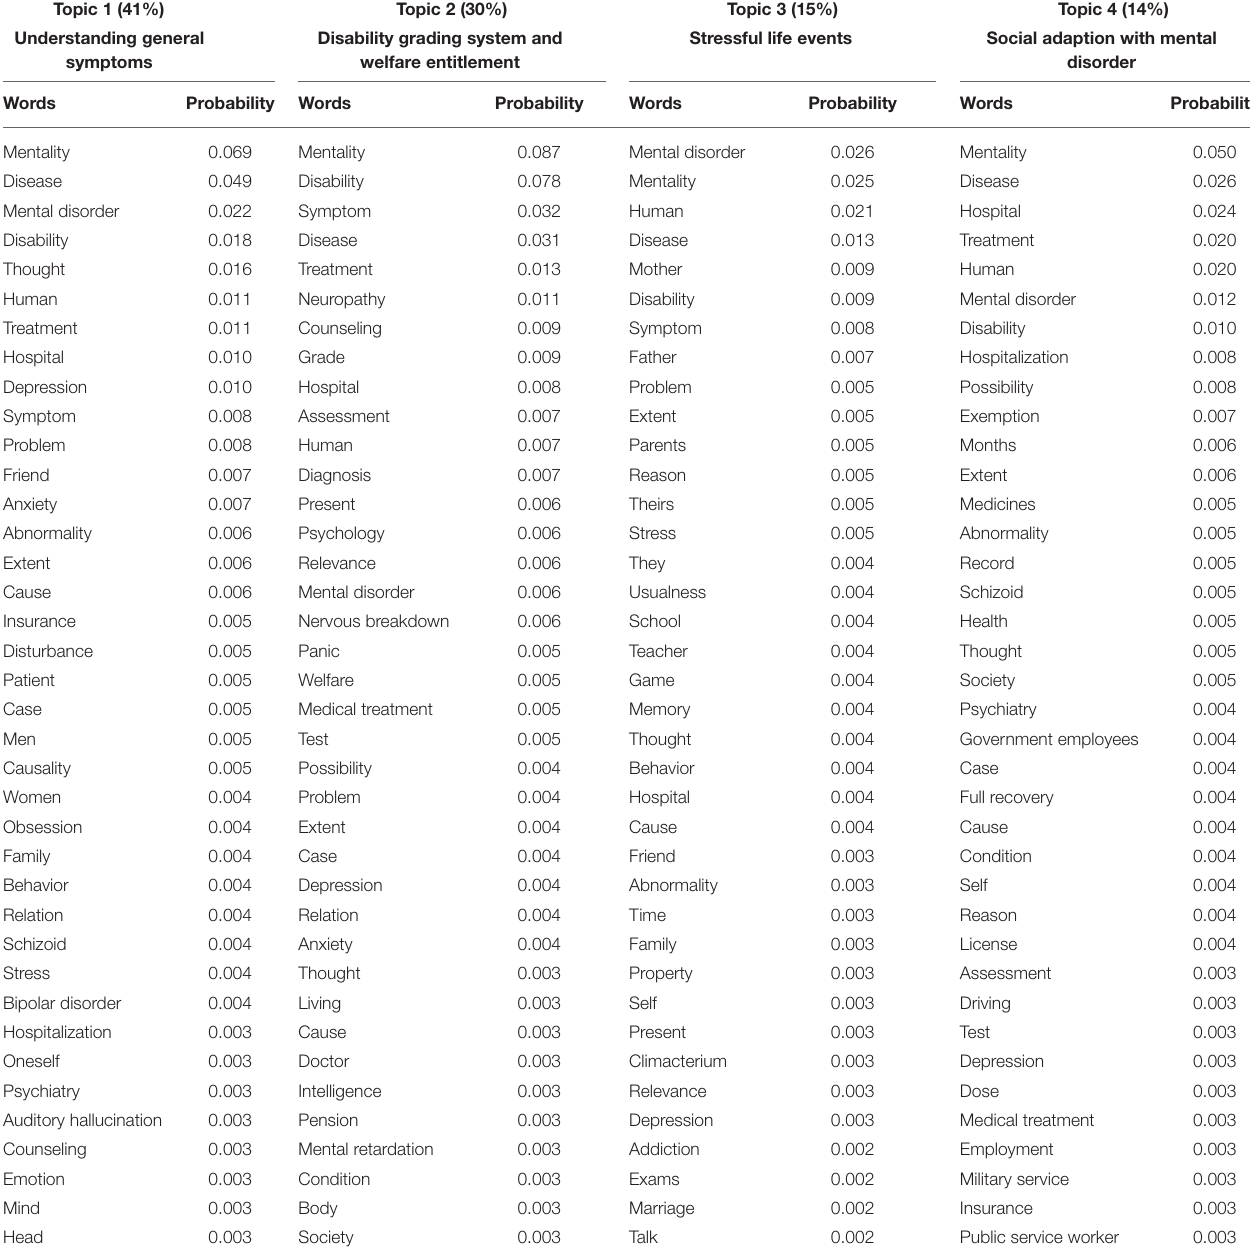
TABLE 2 | Four topic